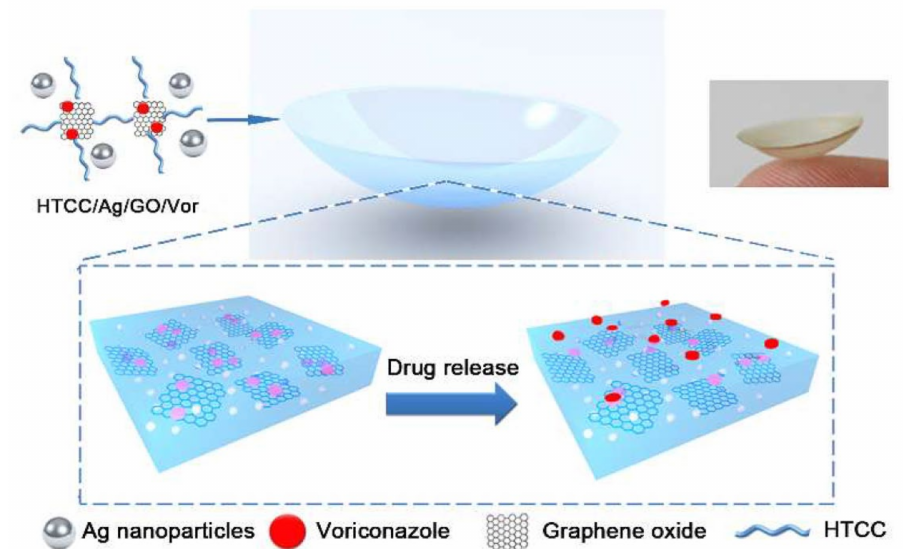
Figure 4. A graphical image of a contact lens loaded with drugs and controlled drug delivery. Reprinted with permission from Wei et al. (2019). Copyright 2019 ACS Publications, ACS